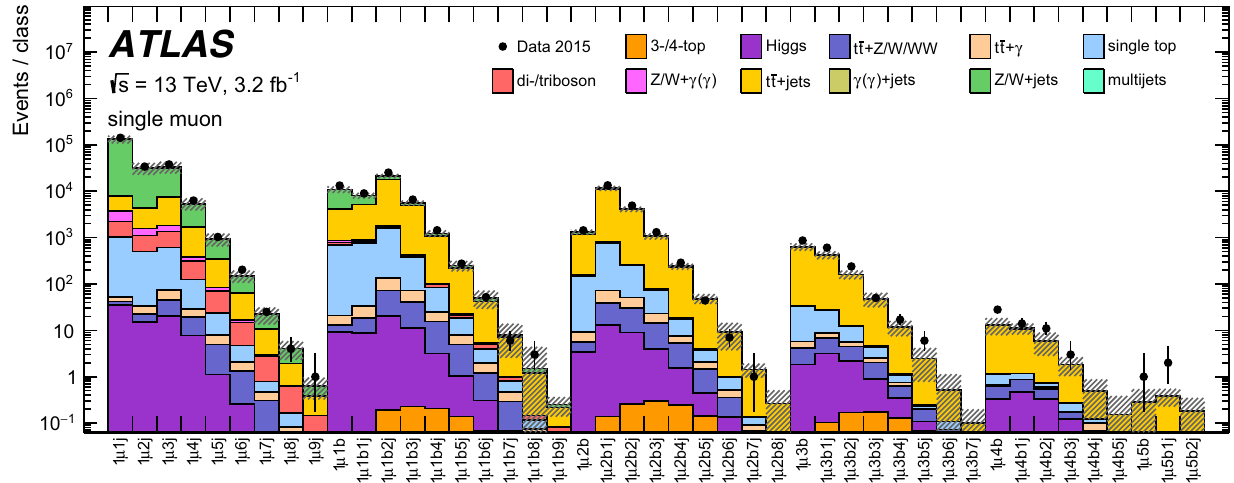
Fig. 13 The number of events in data, and for the different SM back- ground predictions considered, for classes with one muon and ( b -)jets (no electrons, photons or E miss ). The classes are labelled according to T